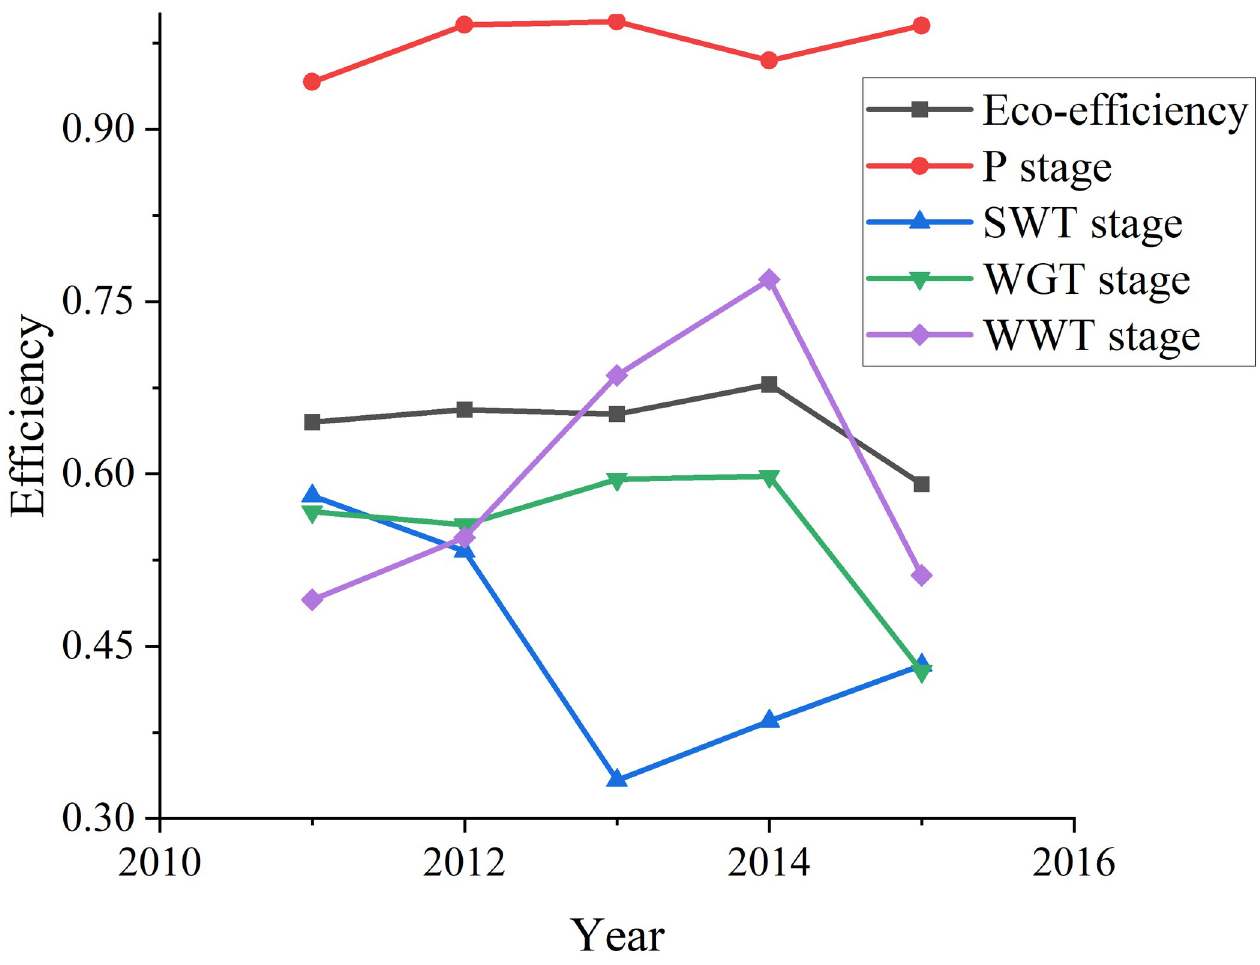
Fig 5. Average period efficiencies during